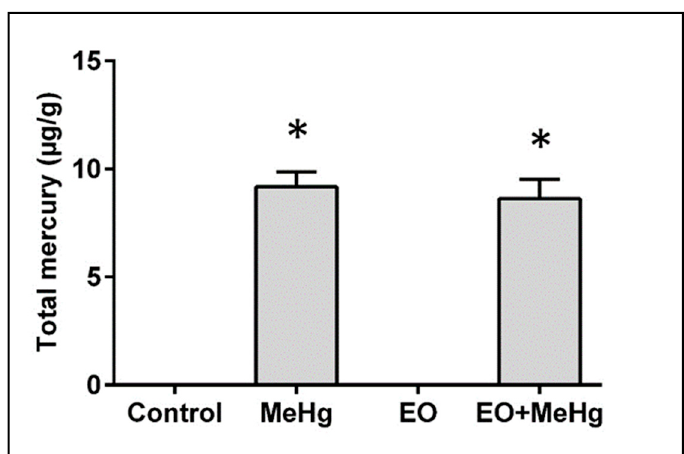
Figure 8. Euterpe oleracea consumption does not alter total mercury content in brain. Mice were treated with clarified E. oleracea juice (EO) once a day for 8 days and/or methylmercury (MeHg) for 4 days. Data are presented as mean ± SEM ( n = 6–8). * P < 0.05 vs control and EO groups.